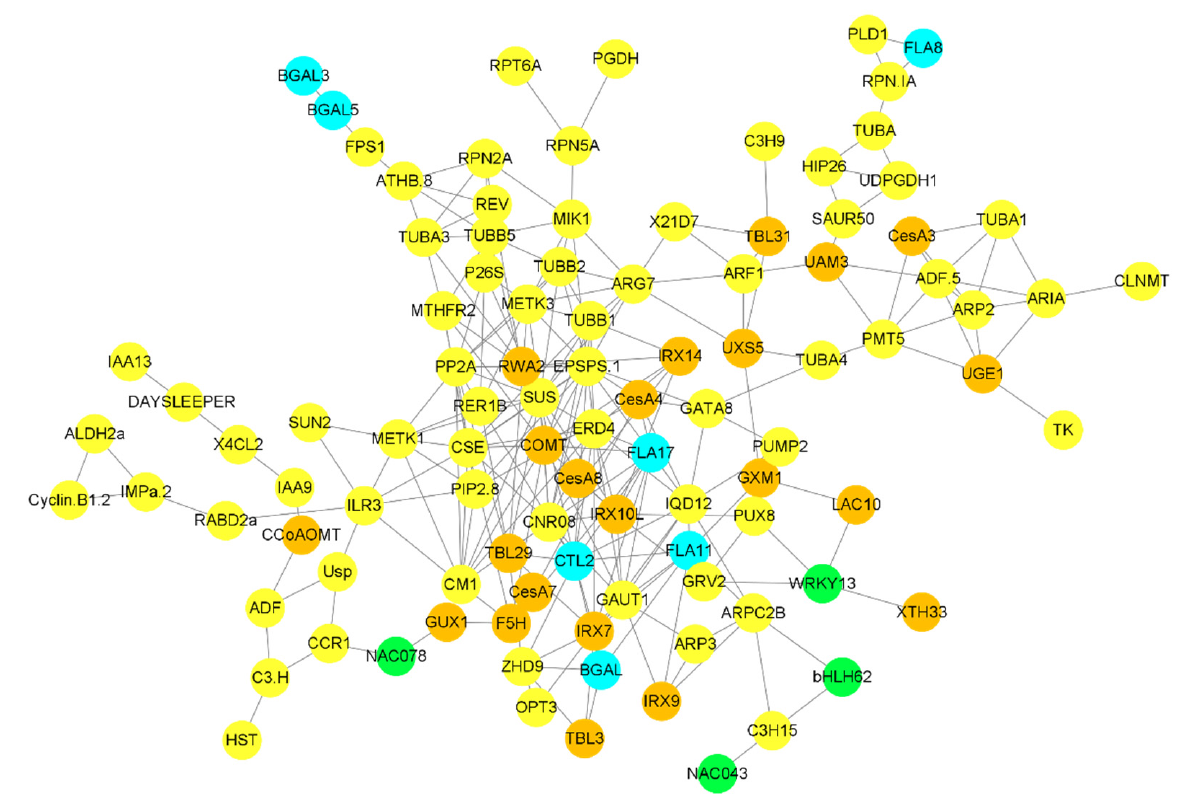
Figure 6. Correlation network between G layer-forming genes and other genes and TFs involved in different biological processes. Only highly expressed and correlated genes were used to build the network. A sky-blue color indicates genes involved in G layer formation, brown circles highlight genes involved in cell wall biosynthesis, green circles highlight TFs, and all other genes highly correlated with G layer forming genes are highlighted in yellow.